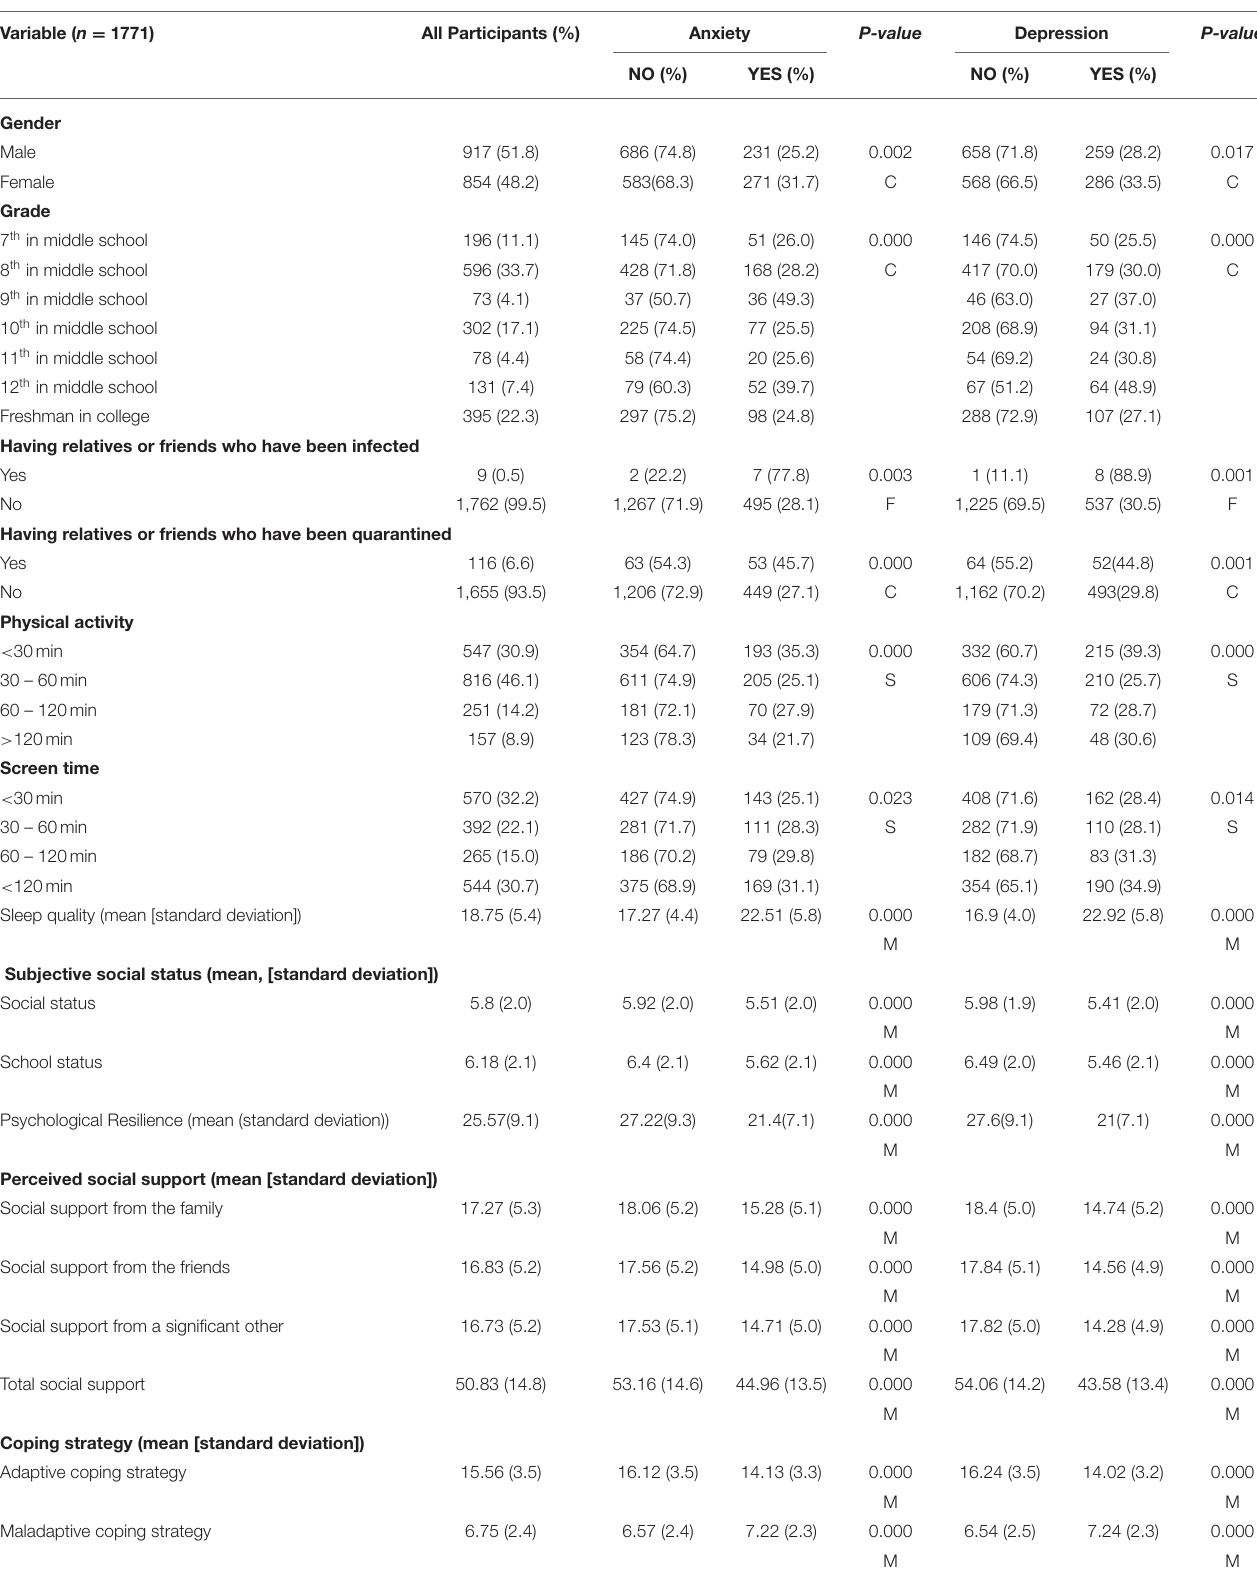
TABLE 1 | Descriptive analysis of the 1,771